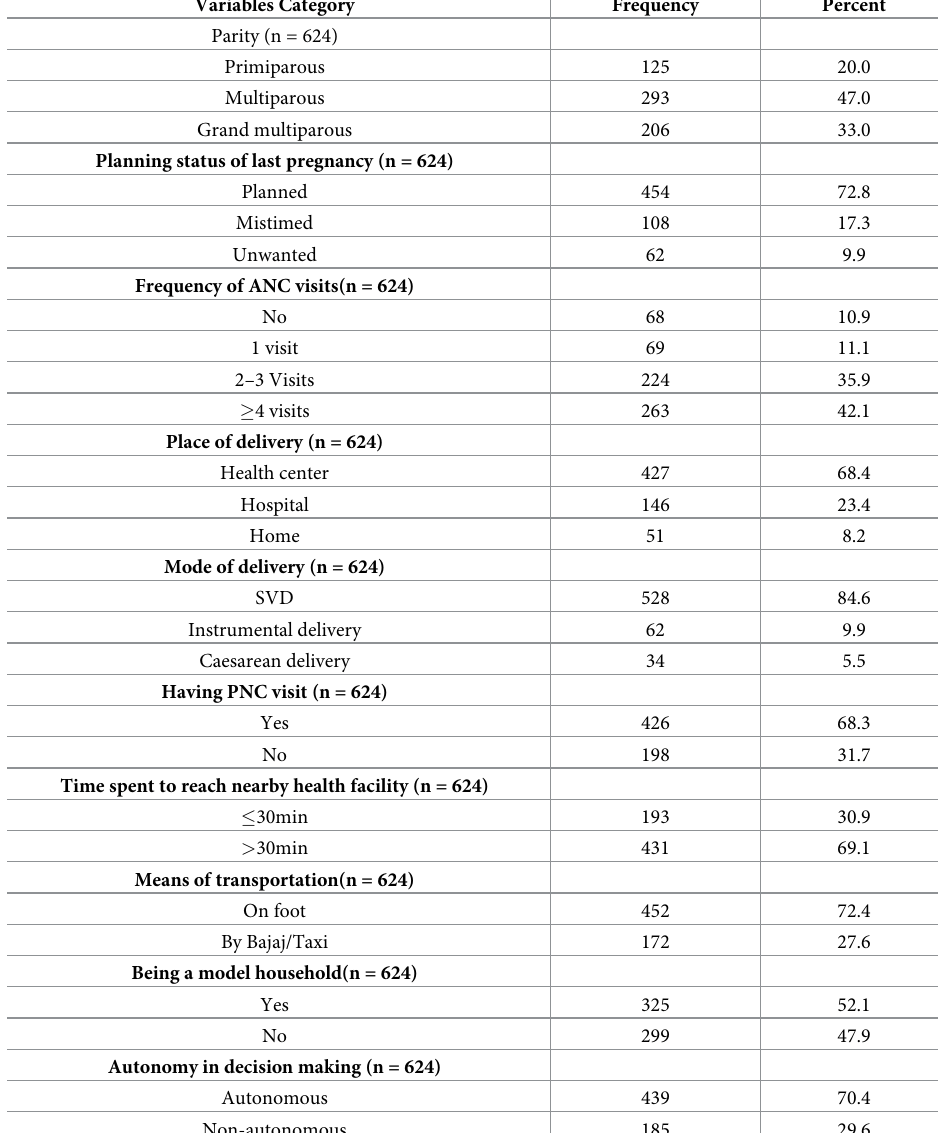
Table 2. Maternal and child health service utilization patterns of mothers of children aged 6–24 months old in Lemo District, Southern Ethiopia,